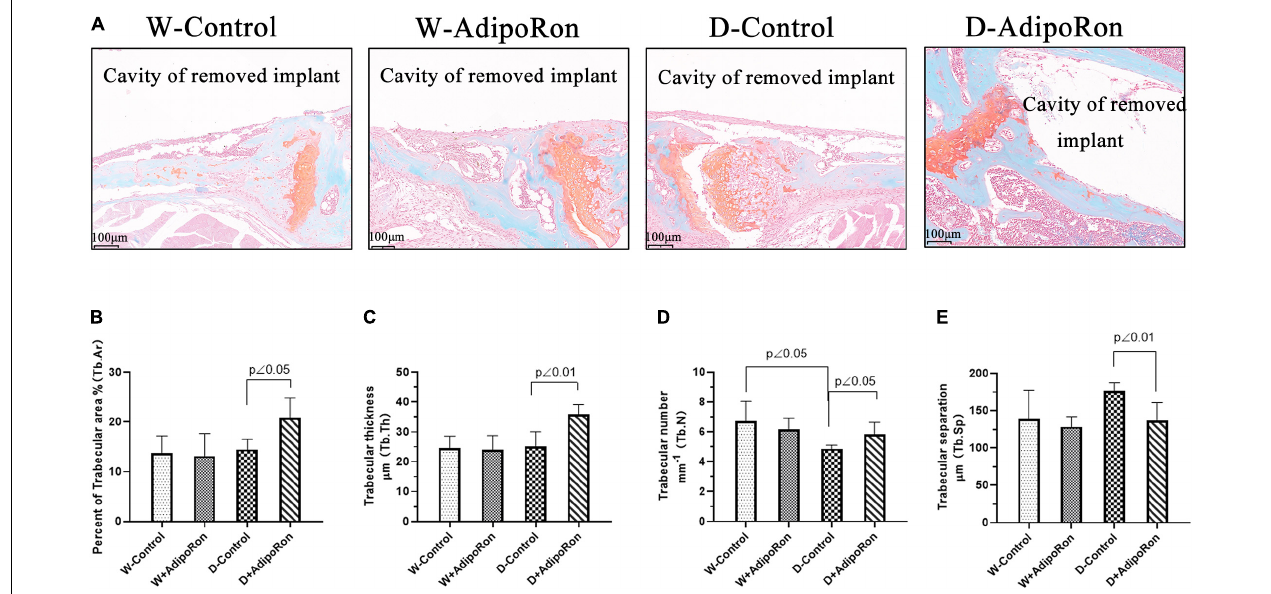
FIGURE 3 | The osteoclast formation was measured using Safranin O-fast green staining. Normal mice (Wild-control, W-control), normal mice treated with AdipoRon (Wild + AdipoRon, W + AdipoRon), diabetic mice (Diabetes-control, D-control), and diabetic mice treated with (Diabetes + AdipoRon, D + AdipoRon) were involved ( n = 7). (A) Femoral bone with dental implants in mice was stained using Safranin O-fast green. One section in the region surrounding the explant of each sample was selected for analysis and five fields of vision were randomly selected in each section. Percentage of trabecular area (Tb.Ar) (B) , trabecular thickness (Tb.Th) (C) , trabecular number (Tb.N) (D) , and trabecular separation (Tb.Sp) (E) were analyzed.